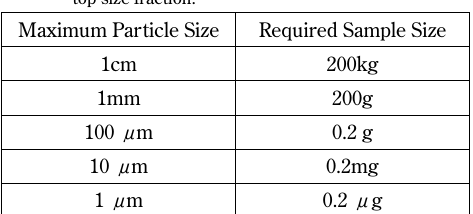
Table 2 Required sample size for determination of the size distribution of powder with relative error less than 5%. Particle density 2.5 g/cm 3 ; 1% by weight in the top size